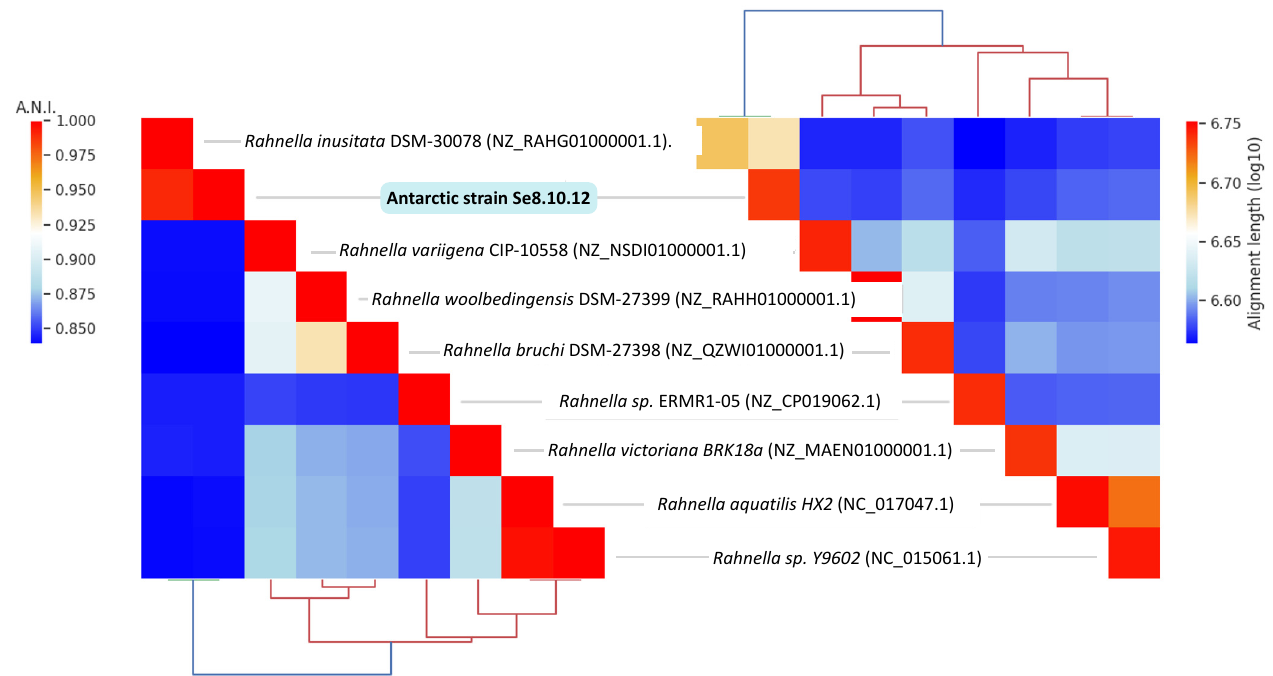
Figure 5. Hierarchically clustered heatmap of Average Nucleotide Identity (ANI) calculated using BLASTn method ( left ), and alignment length ( right ) between nine Rahnella species genomes including the Antarctic isolate Se8.10.12. GenBank accession numbers are provided in brackets.